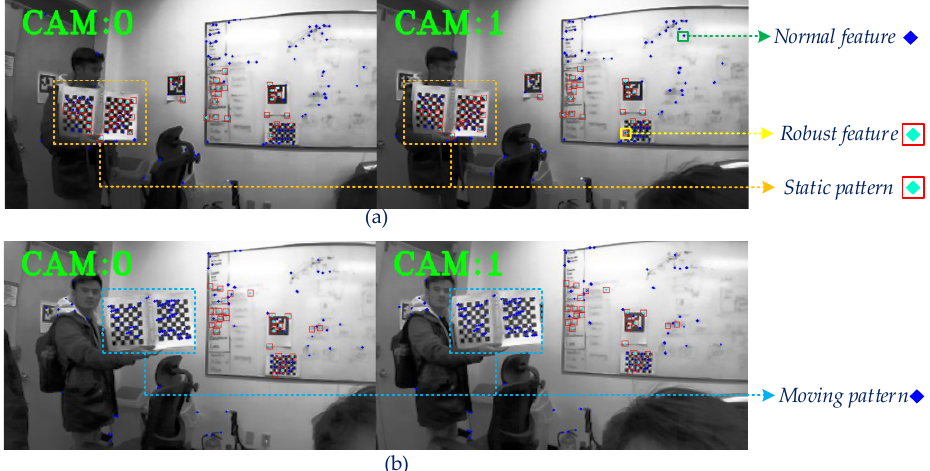
Figure 12. Screen snapshots using the Robot Operating System (ROS) image toolbox during the indoor lab test with a dynamic pattern. ( a ) In this case, the pattern is static and many features identified the robust feature. ( b ) When the pattern begins moving, the robust feature turns to the normal feature.